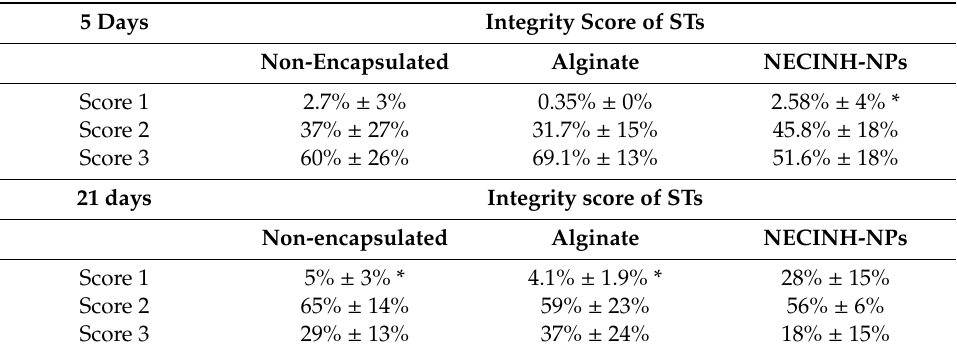
Table 2. Impact of NECINH-nanoparticles(NPs)-loaded hydrogel on mice testicular tissue after autotransplantation for 5 and 21 days. Results for tissue integrity are expressed as the mean percentage of STs (seminiferous tubule sections) for each integrity score and condition ± standard deviation. n = 30. * indicates p < 0.05 relative to day 21 Score 1 NECINH-NPs.